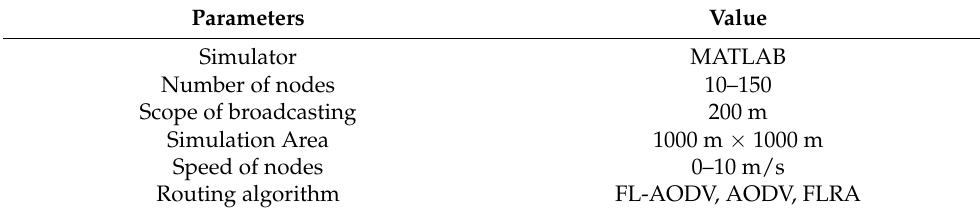
Table 2. Parameter